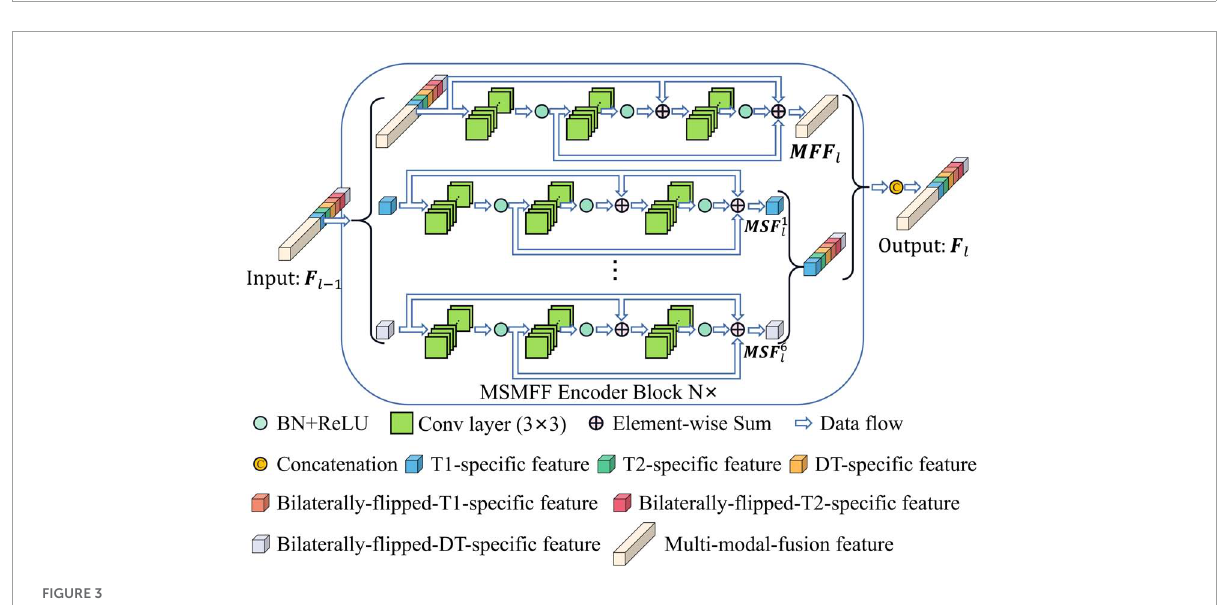
FIGURE3 Modality-specific and multi-modal fusion feature encoder